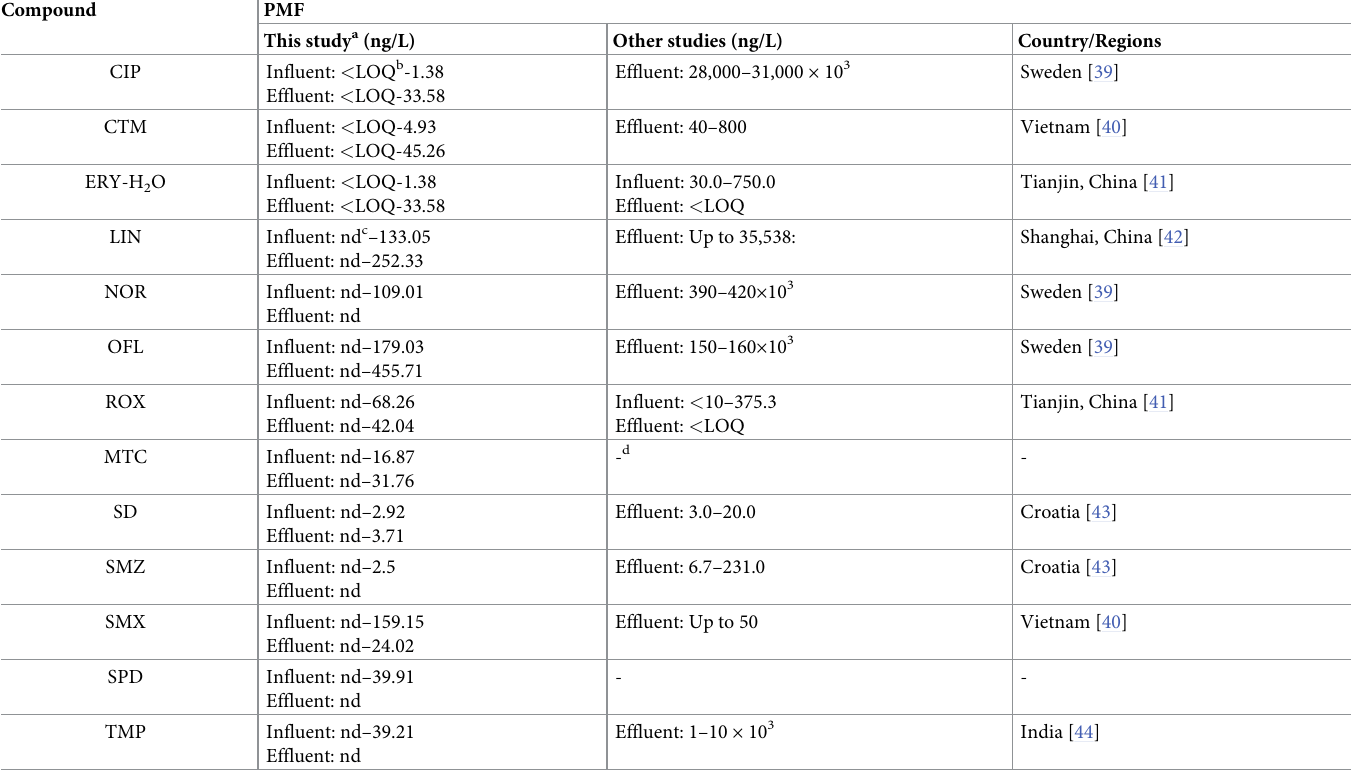
Table 2. Comparison of the antibiotic concentration levels in wastewater samples between this study and previous studies.